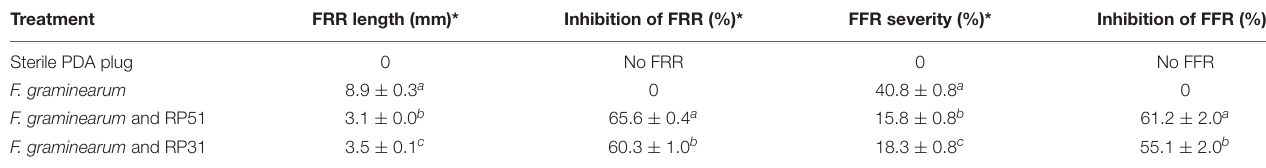
TABLE 5 | Fusarium root rot (FRR) and Fusarium foot rot (FFR) in wheat seedlings controlled by Paenibacillus peoriae RP51 and Paenibacillus sp. RP31. Treatment Sterile PDA